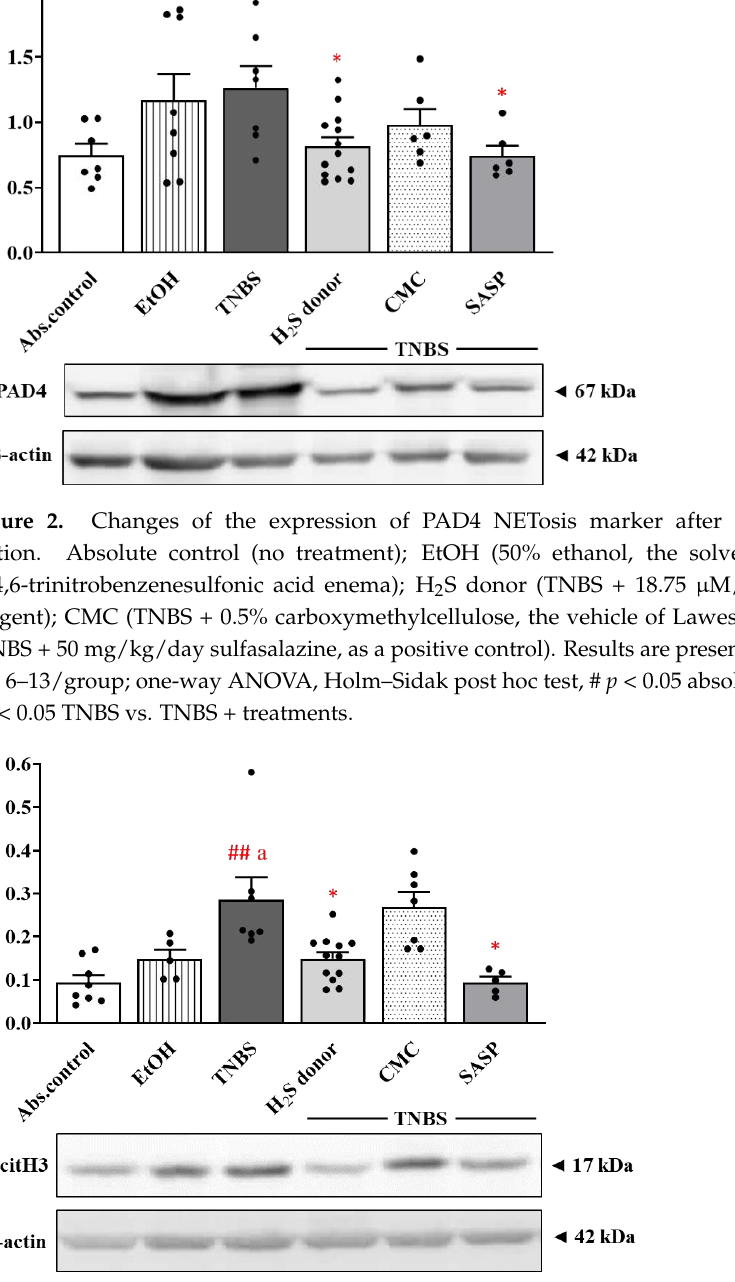
Figure 3. The expression of citH3 after TNBS administration and H 2 S donor treatments in rat colon tissues. Absolute control (no treatment); EtOH (50% ethanol, the solvent of TNBS); TNBS (2,4,6-trinitrobenzenesulfonic acid enema); H 2 S donor (TNBS + 18.75 μM/kg/day Lawesson’s reagent); CMC (TNBS + 0.5% carboxymethylcellulose, the vehicle of Lawesson’s reagent); SASP (TNBS + 50 mg/kg/day sulfasalazine, as a positive control). Results are presented as mean + S.E.M.; n = 5 – 12/group; one-way ANOVA, Holm – Sidak post hoc test, ## p < 0.001 absolute control vs. TNBS; a p < 0.05 EtOH vs. TNBS; * p < 0.05 TNBS vs. TNBS + treatments.